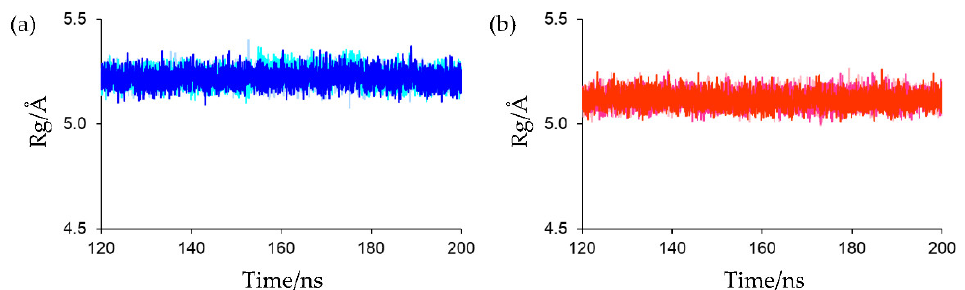
Figure 8. ( a ) Rg plots of protein backbone around the active site for oxidized Fd. Rg plots of the first, second, and third simulations were presented in light blue, cyan, and blue, respectively. ( b ) Rg plots of protein backbone around the active site for reduced Fd. Rg plots of the first, second, and third simulations were presented in light pink, magenta, and red, respectively.